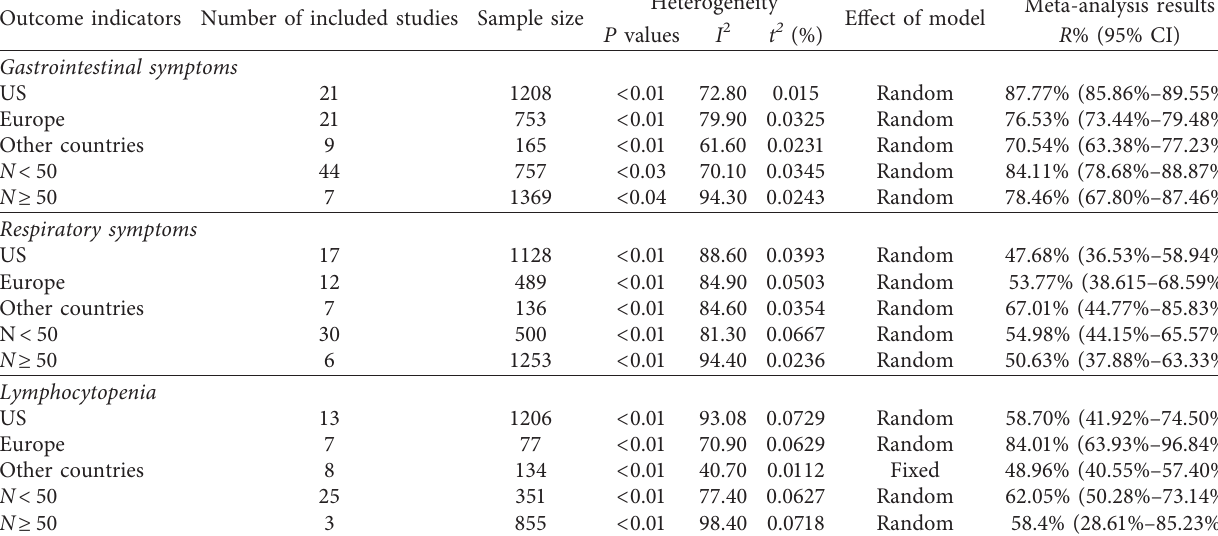
Table 2: Results of subgroup